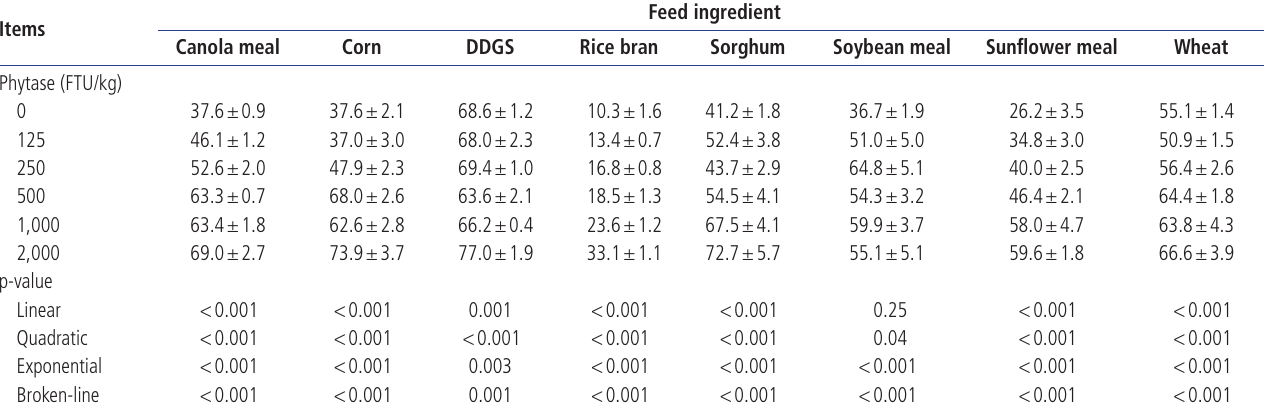
Feed ingredient